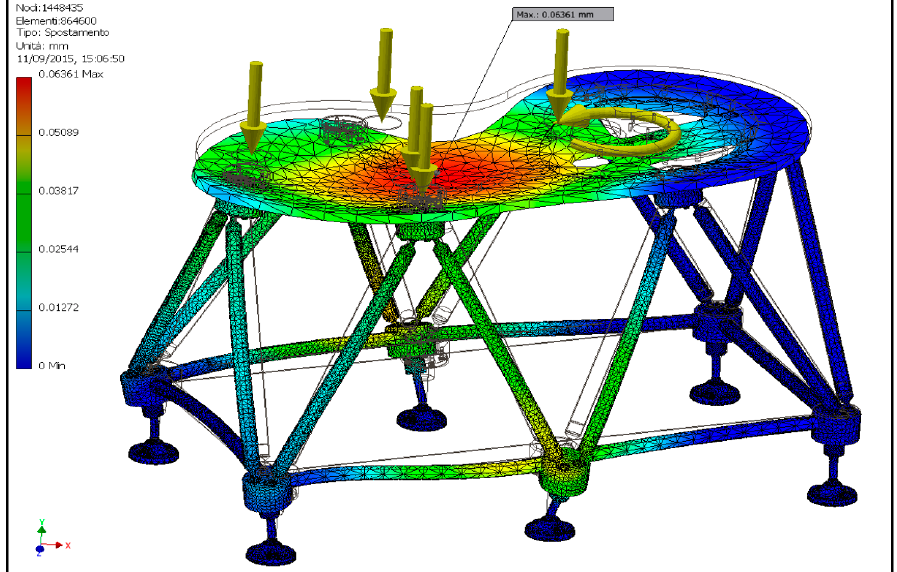
Figure 11. Displacements of the FLEX base for a filler–capper combined unit.